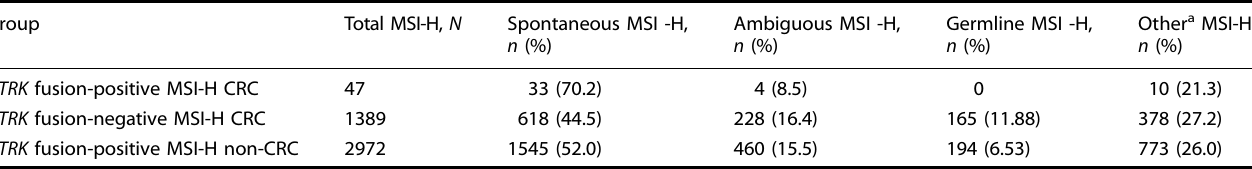
Table 2. Categorisation of MSI-H status among NTRK fusion-positive CRC, NTRK fusion-negative CRC and NTRK fusion-positive non-CRC tumours.